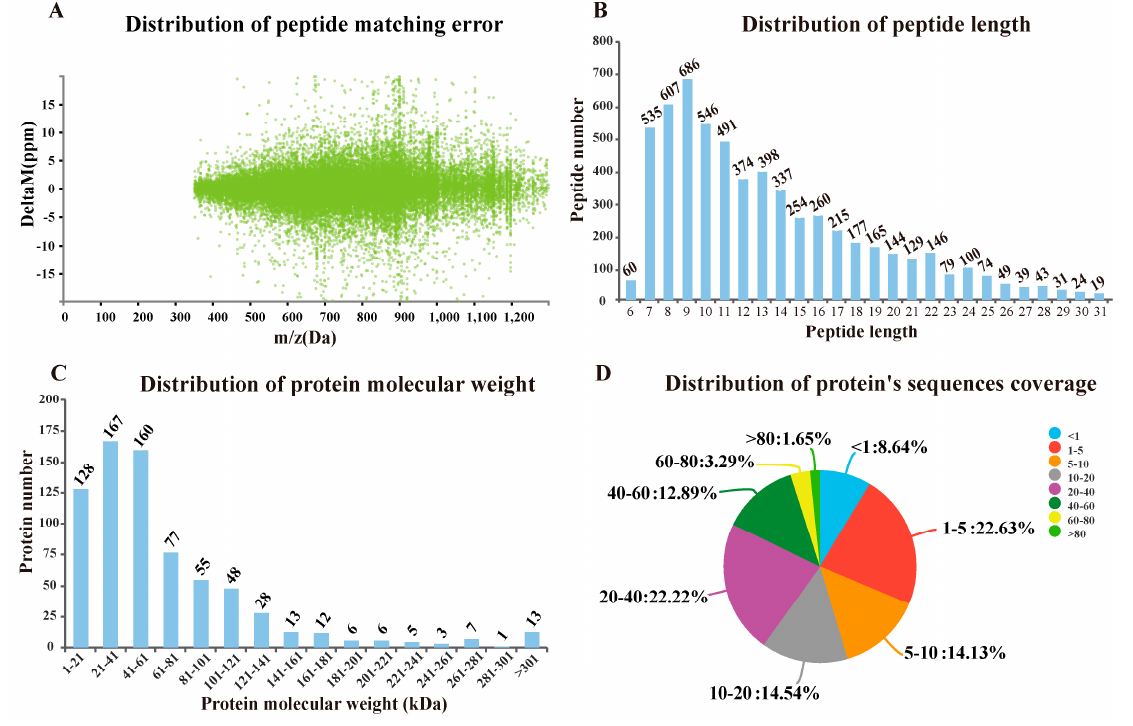
Figure 3. Identification and quantitation of the proteome. ( A ) The distribution of peptide matching error. ( B ) The distribution of peptide length. ( C ) The distribution of protein molecular weight. ( D ) The distribution of protein’s sequences coverage. The number outside the fan indicates the coverage of the protein number in this